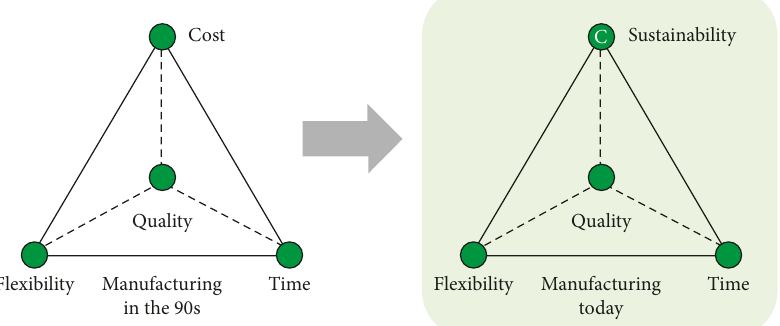
Figure 1: Manufacturing decision-making attributes in the 1990s and at the present time